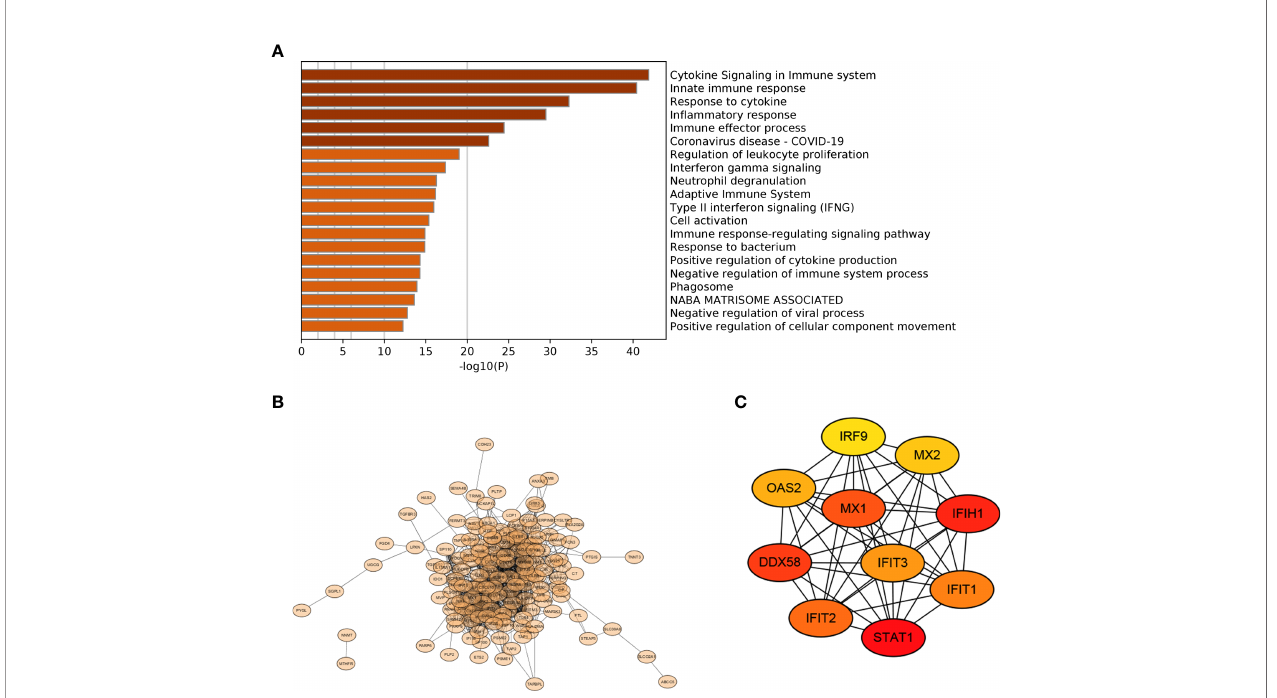
FIGURE 4 | PPI selection of key genes (A) Functional terms of 172 IRDEGs; (B) PPI network diagram of 172 IRDEGs; (C) Top 10 important genes in the MCC